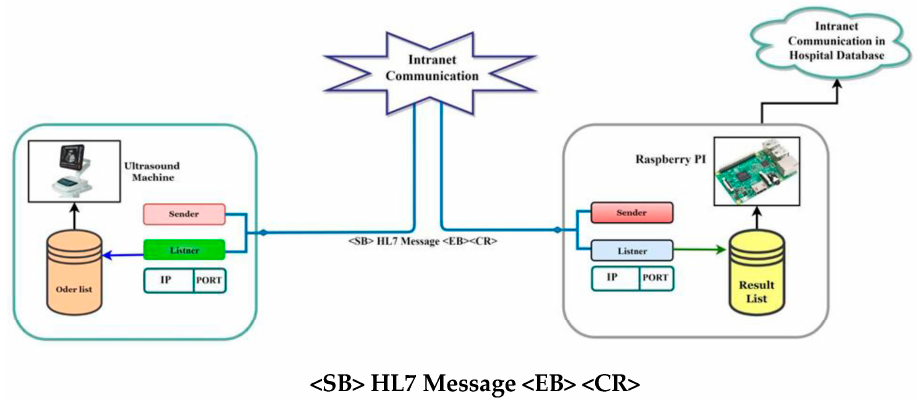
Figure 4. HL7 communication process, ultrasound machine to Raspberry Pi.